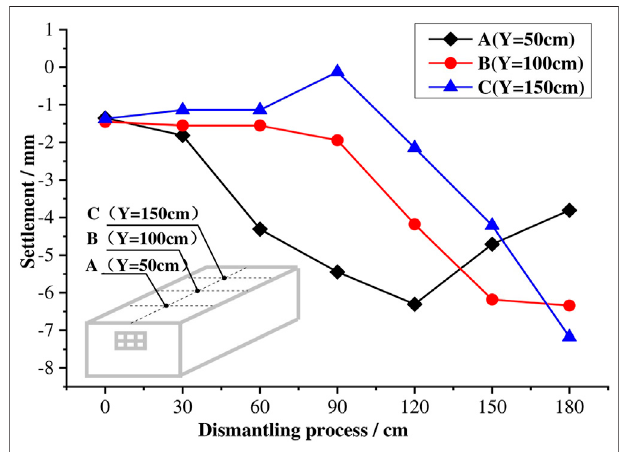
FIGURE 10 | Surface settlement during the dismantling process of temporary lining.